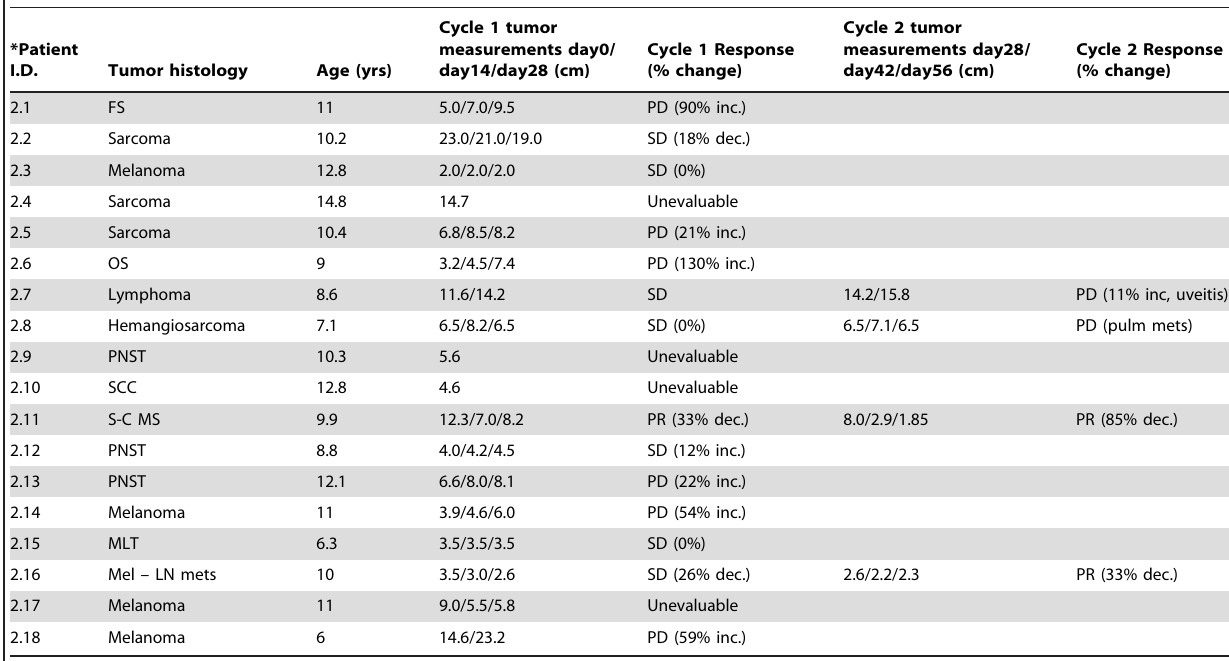
Table 2. RGD-A- TNF Multiple Dose Study: Patient Data and Tumor Responses